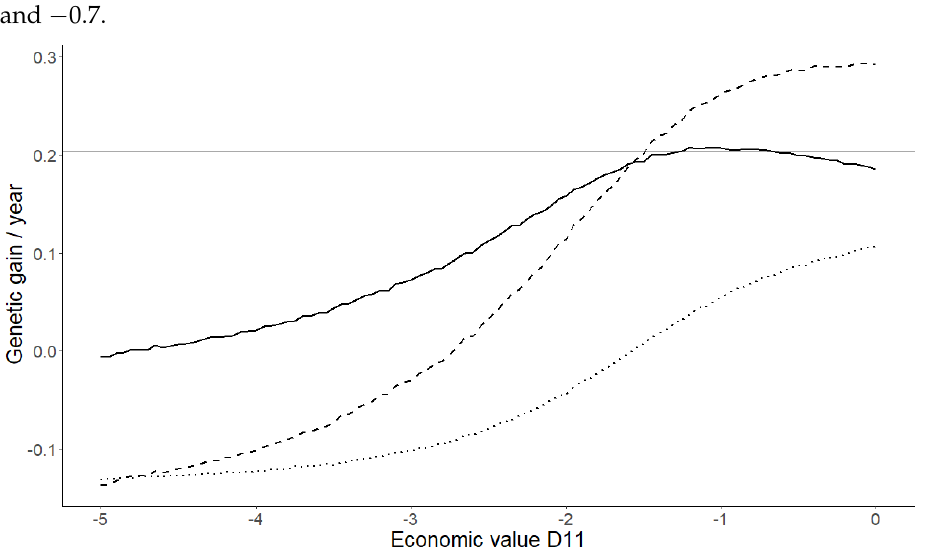
Figure 1. Annual genetic gain for living piglets on day 11 (L11), the total number born (TNB), and the number of dead piglets on day 11 (D11) for simulated breeding schemes with different breeding goals. Grey horizontal line shows the annual genetic gain for L11 when the breeding goal included L11 only. The three black lines show the annual genetic gain for individual traits when using a two-trait breeding goal with TNB and D11. Solid, dashed, and dotted lines indicate annual genetic gain for L11, TNB, and D11, respectively. For all two-trait breeding goals, the economic value was equal to 1 for TNB, and was between − 5 and 0 for D11.